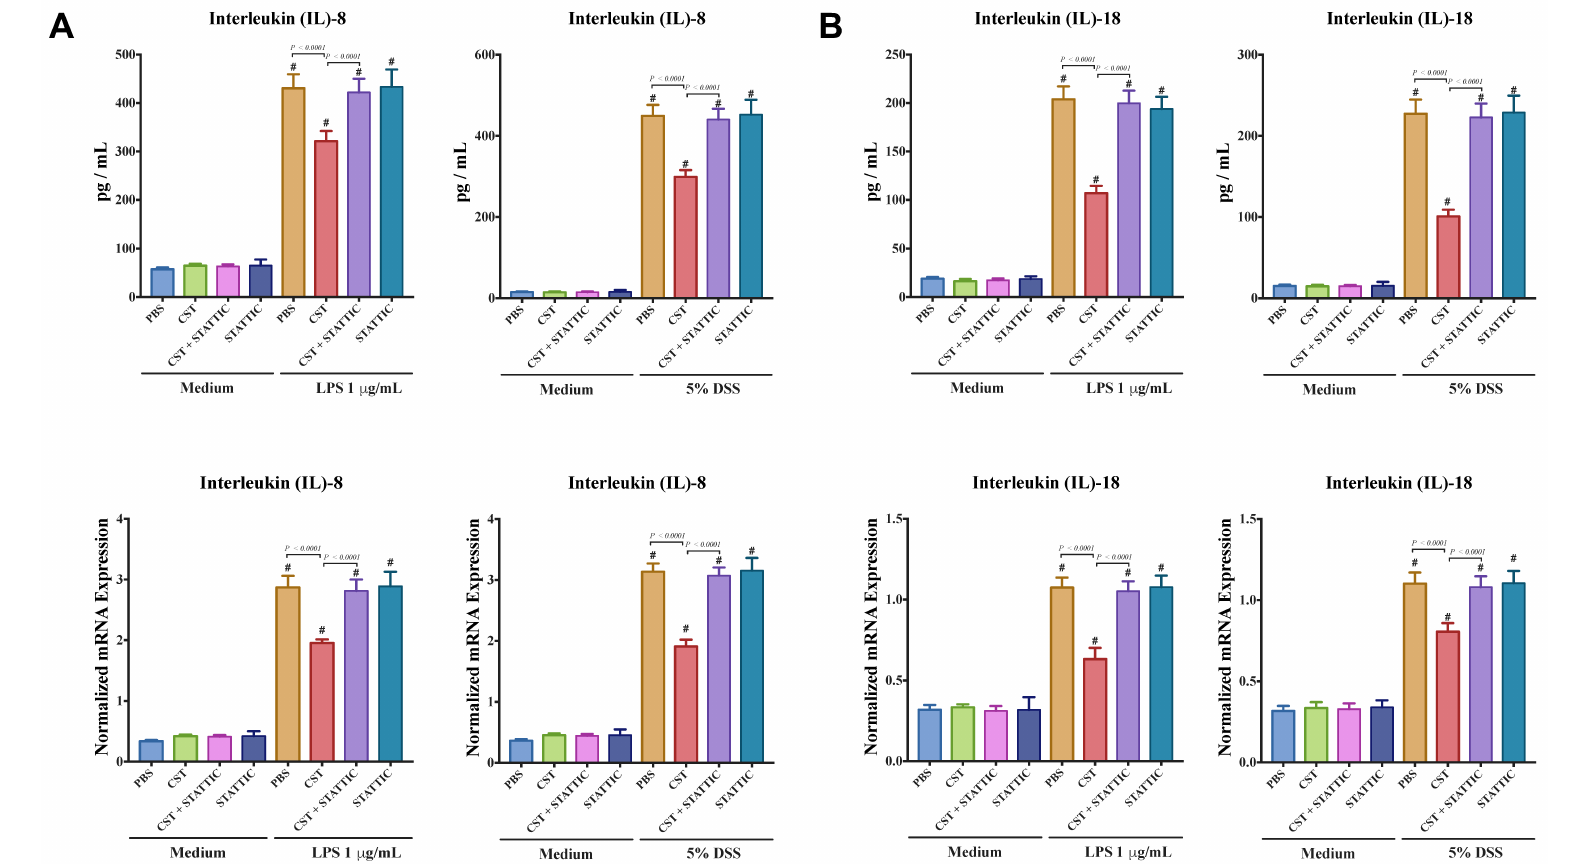
Figure 8. Catestatin (CST) reduces IL-8 and IL-18 release in LPS- and DSS-stimulated Caco-2 epithelial cell line through potentially the STAT3 pathway. Caco-2 cells were treated with 1 × phosphate buffer saline (PBS) or CST (100 ng/mL) in medium for 24 h then challenged with LPS (1 µ g/mL) or 5% DSS for an additional 24 h in the presence or absence of STAT3 inhibitor (10 − 5 M, STATTIC; Sigma, Mississauga, ON, Canada). ( A , B ) Protein and mRNA levels expression of IL-8 and IL-18 in LPS- and DSS-stimulated epithelial cells. One-way ANOVA was used to analyze the data followed by multiple comparison tests. Data represent mean ± SEM ( n = 6–9). # Compared to control groups. Each experiment was repeated at least three